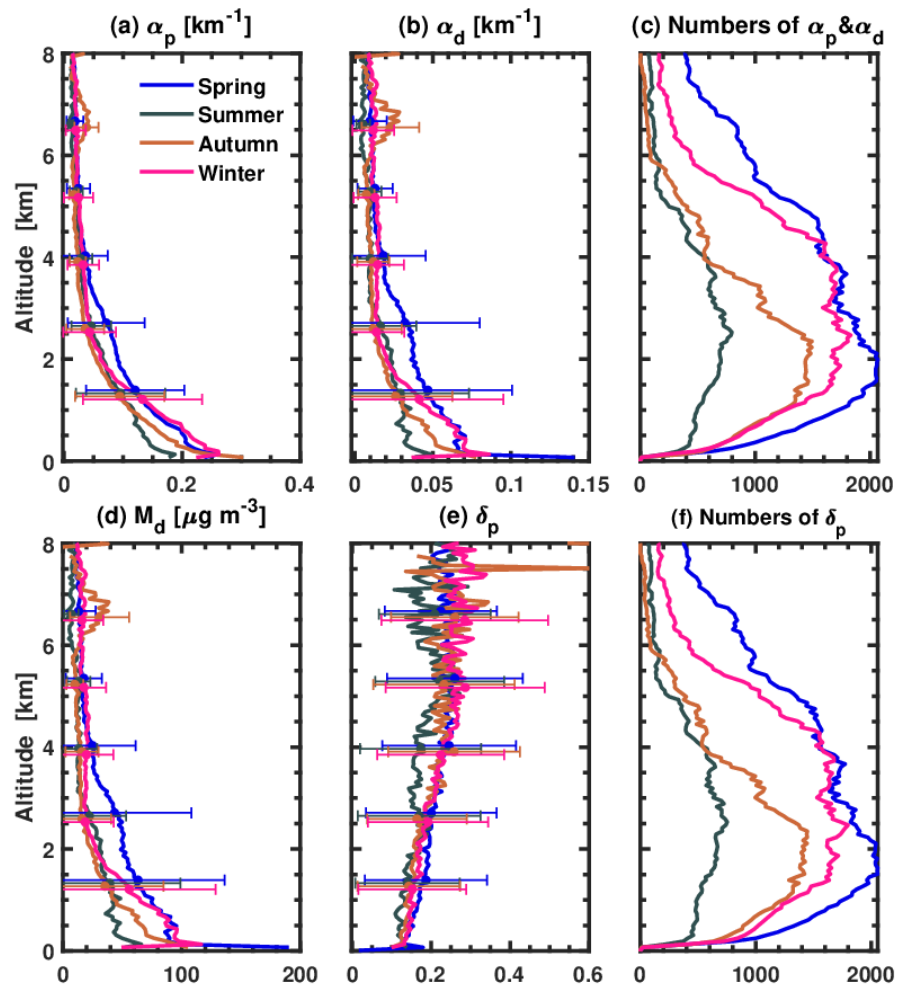
Figure 4. Seasonally averaged ( a ) extinction coefficient α p , ( b ) dust extinction coefficient α d , ( d ) dust mass concentration M d , ( e ) particle depolarization ratio δ p , and the number of ( c ) α p and α d , and ( f ) δ p , observed by CALIOP over the Jianghan Plain (29 ◦ –32 ◦ N, 111 ◦ –114.5 ◦ E) from June 2006 to March 2021. These are calculated by the annual average with altitude, which is the layer that contains dust. Horizontal lines denote the standard deviation of each variable.